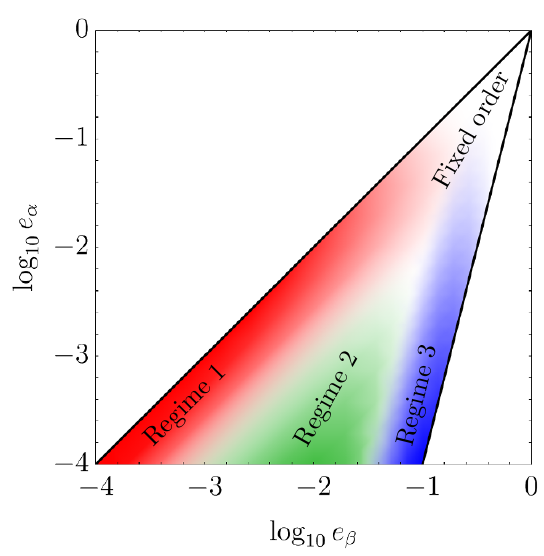
e (cid:11) and (cid:12) and the various regimes